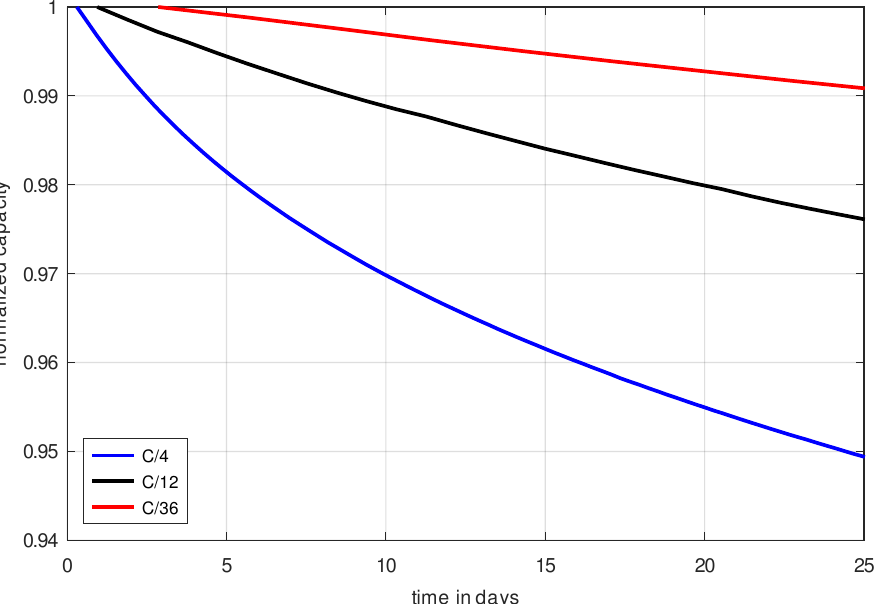
Figure 11. Normalized capacity decrease observed over the measurement time. For this purpose, an LG INR18650 MJ1 cell was cycled with C/4, C/12 and C/36 at 40 °C ambient